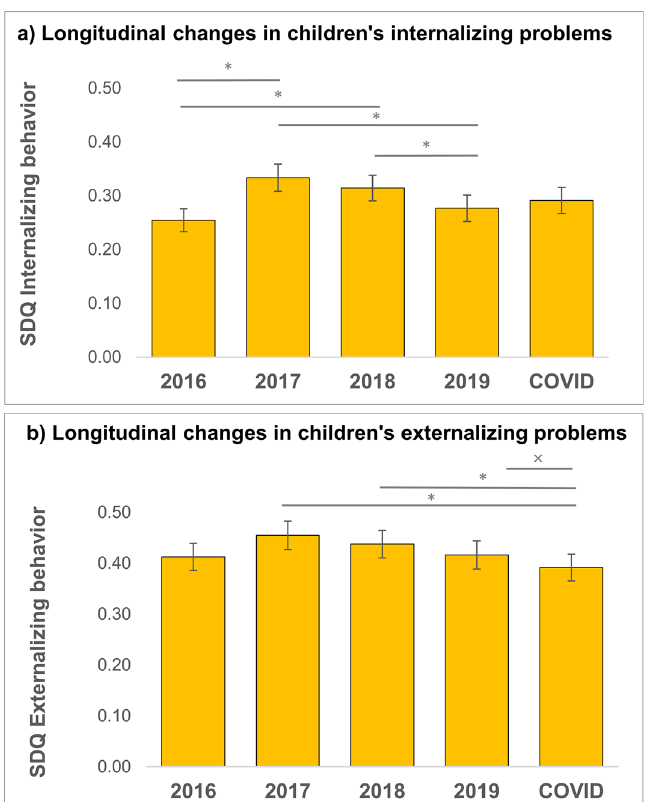
Figure 2. Longitudinal changes in internalizing ( a ) and externalizing ( b ) behavior in children. Asterisk indicate significant differences ( p < .05), crosses indicate marginally significant differences ( p = .056).